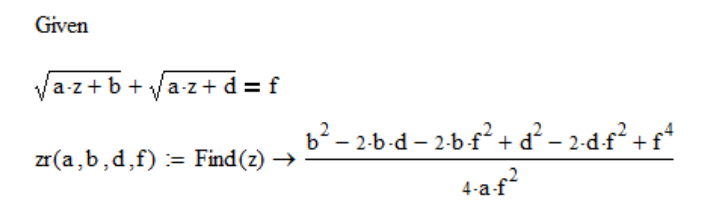
Figure 2. Listing of the Mathcad program for the symbolic solution of Equation (1) if a = c.